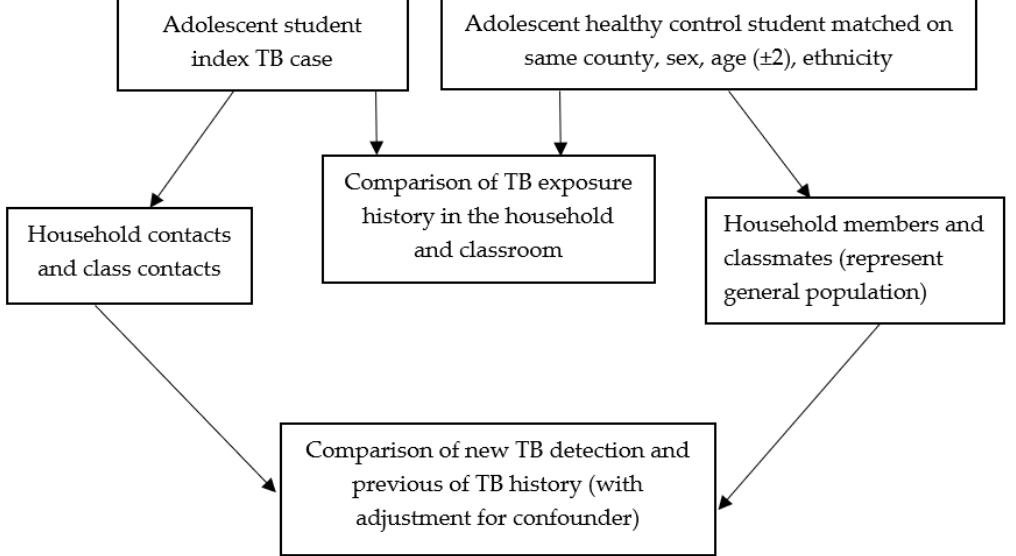
Figure 1. The framework of data analysis.